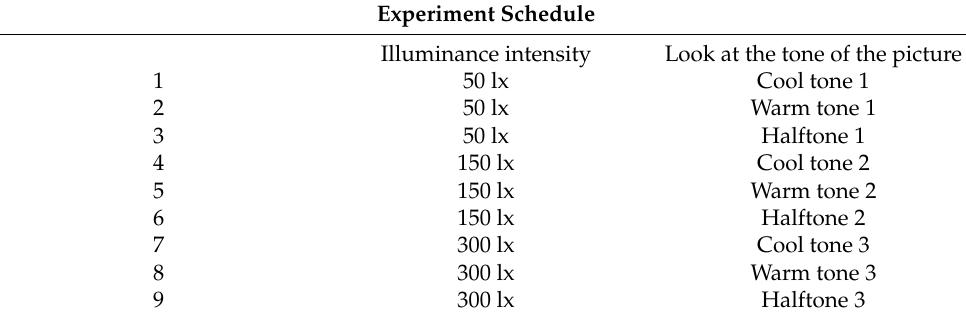
Table 5. Experiment schedule.